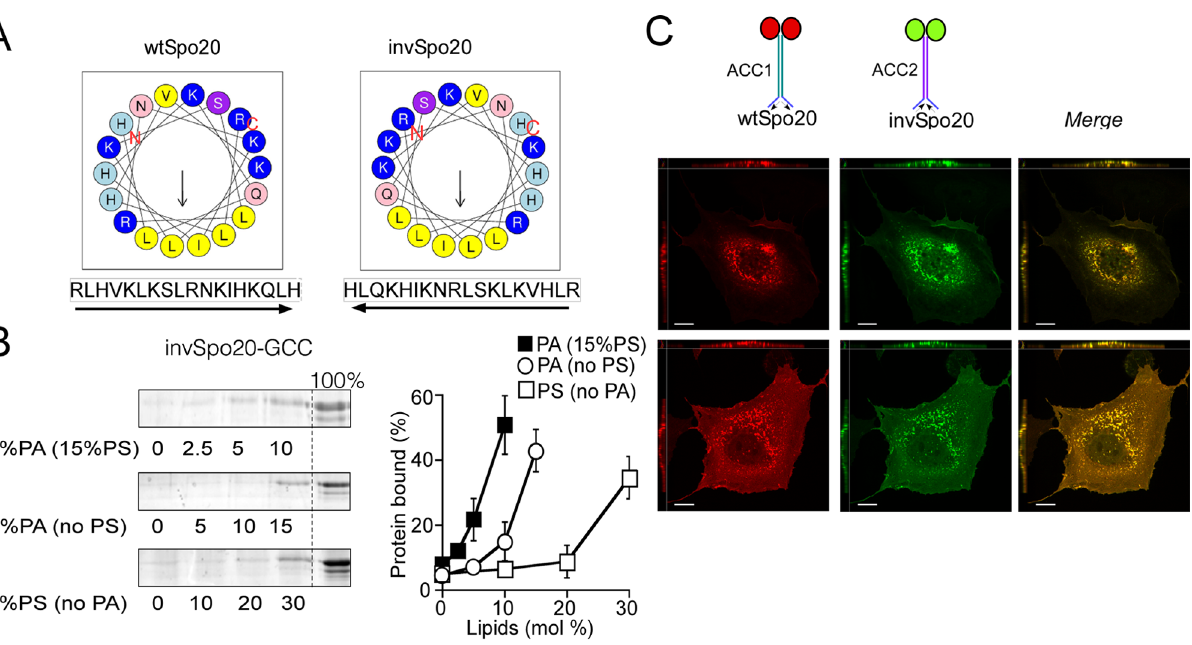
Figure 7. Inverting the Spo20 sequence affects neither its specificity for negatively charged lipids nor its subcellular localization. ( A ) Helical wheel representations of the Spo20 sequence and of the corresponding inverted mutant (iSpo20) where the sequence is read from the C- to the N-terminus. ( B ) Flotation Assays. Binding of iSpo20-GCC to liposomes (0.75 mM lipids; extrusion 0.2 m m) containing (mol %) PE (25), cholesterol (25), PS (0, open symbols; 15, filled symbols) and increasing amounts of PA. The experiment was repeated two or three times with different preparations of liposomes. Data show mean ¡ S.E of these independent experiments. ( C ) Confocal microscopy images of RPE1 cells after transfection with Spo20-ACC1-mCherry and iSpo20-ACC2-GFP. xy planes and z projections are shown. Note that the two probes co-localize almost perfectly. Scale bars 5 10 m m.